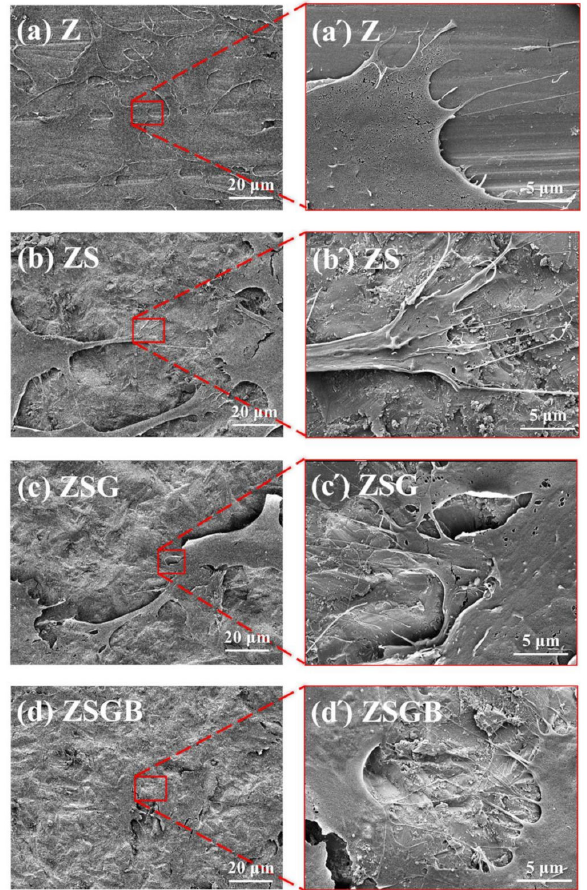
Figure 4. FESEM micrographs showing the cell morphology on test specimens after 6 h of incubation: ( a ) Z (untreated zirconia), ( b ) ZS (sandblasted Z), ( c ) ZSG (genipin-treated ZS), and ( d ) ZSGB (BMP-2-immobilized ZSG); the micrographs ( a’ – d’ ) are partial enlarged views of the micrographs ( a – d ), respectively.